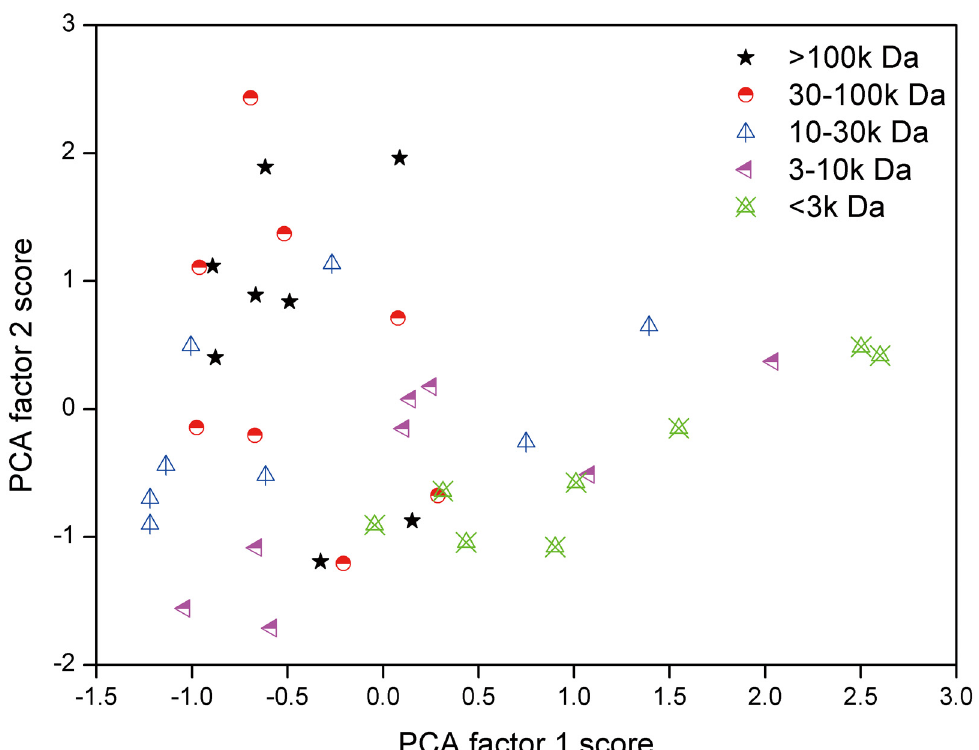
Fig 4. PCA factor scores of all the samples classified by different MW. > 100k Da fraction; 30-100k Da fraction; 10-30k Da fraction; 3-10k Da fraction; < 3k Da